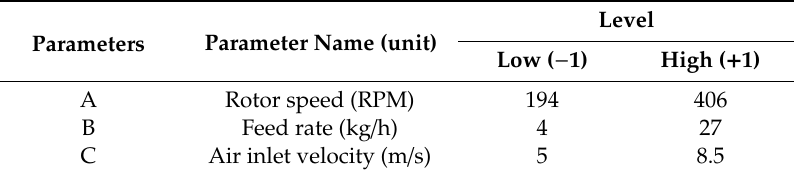
Table 1. Operating parameters and their levels.